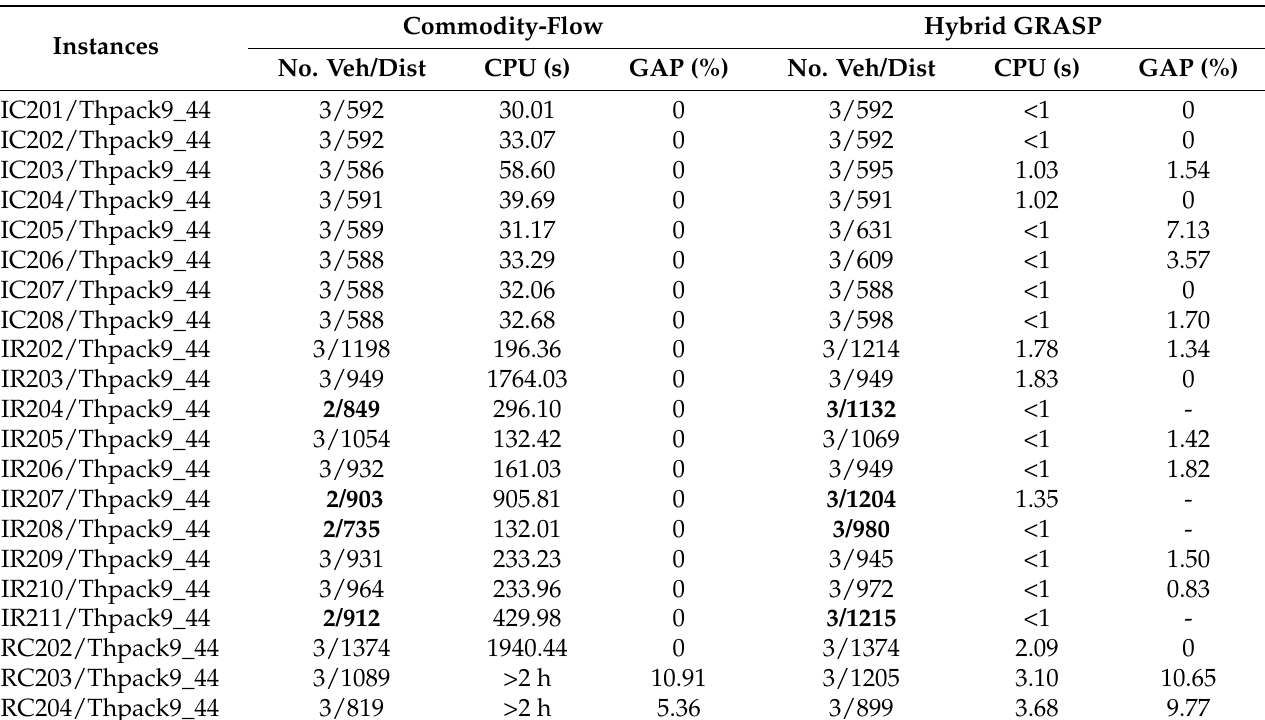
Table 4. Experimental results for the adapted benchmark instances for the VRPSDPTW and 3D-BPP (routing and loading several